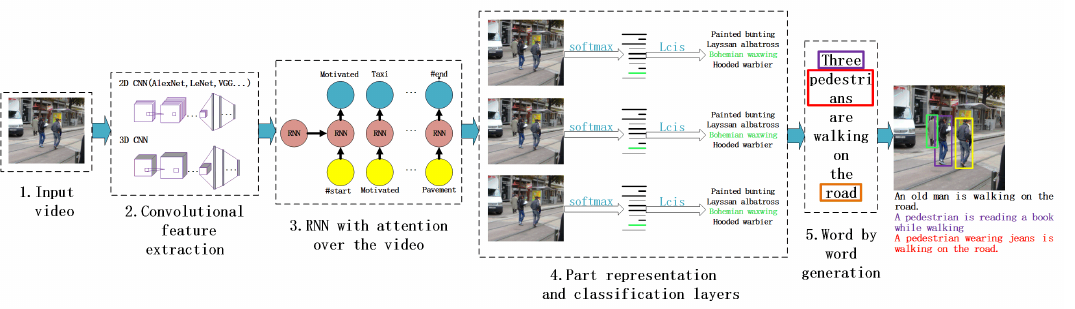
Figure 11. A CNNs-RNNs process in pedestrian tracking and road identification